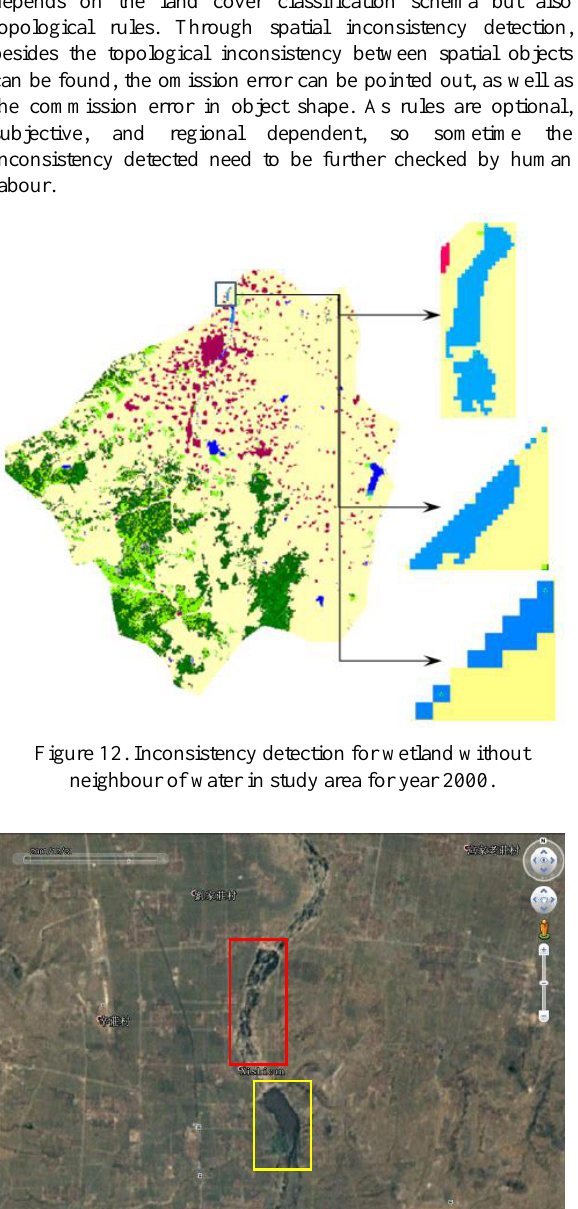
Figure 13. Available Google Earth image 2009 for inconsistency detected in figure